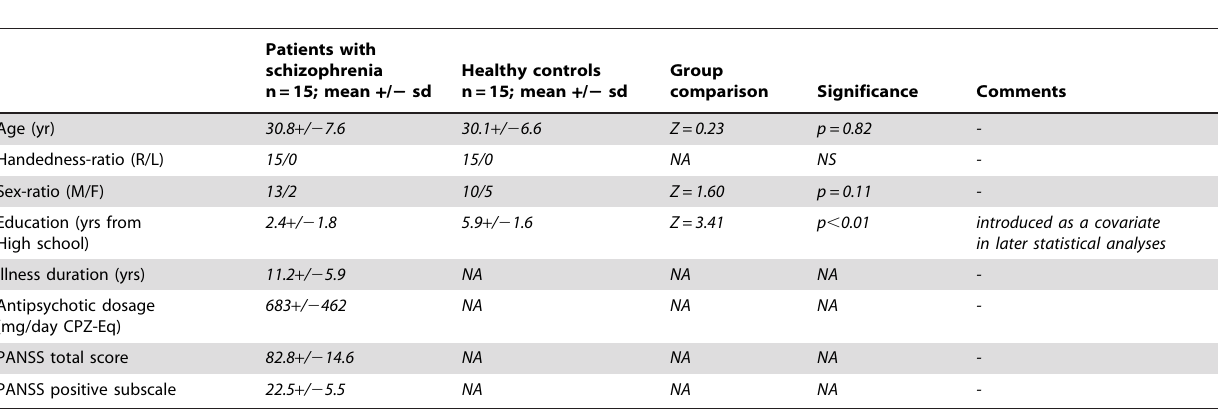
Table 1. Demographic information of the participants included in the ‘implicit self-other distinction’ study (n=30).